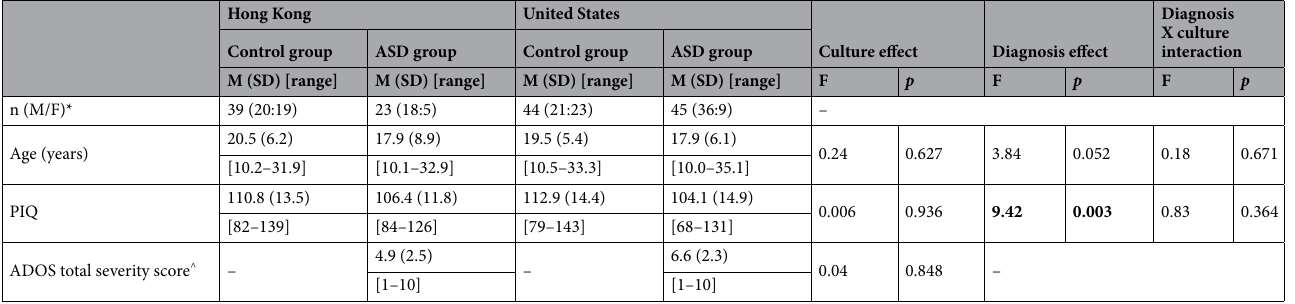
Table 1. Sample characteristics—RAN. Bold indicates significance p < .05. *Sample size reflects image with maximum number of participants. ^ ADOS total comparison severity score labels are as